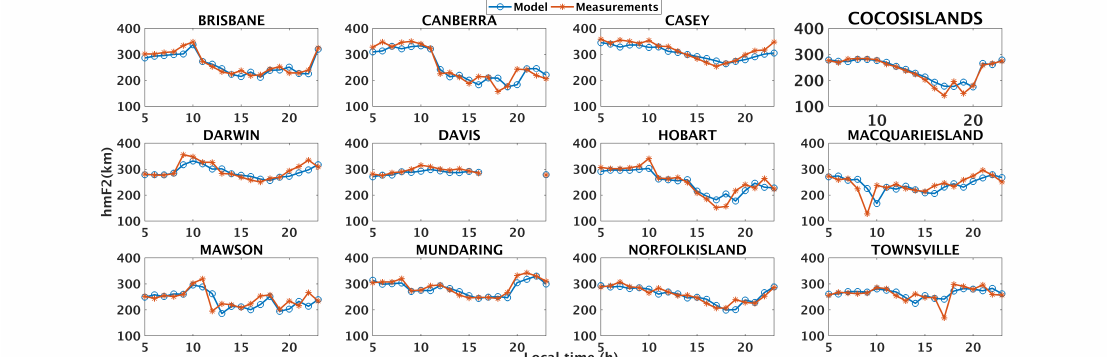
Figure 13. Comparison between the results from the bi-LSTM model and ionosonde measurements in January at 12 different ionosonde stations. Each panel is for one station. Blue cycles and red asteroid denote the model prediction and measurements respectively. In each panel, X axis is local time and Y is hmF2 (km) (in the same range between 100 to 400